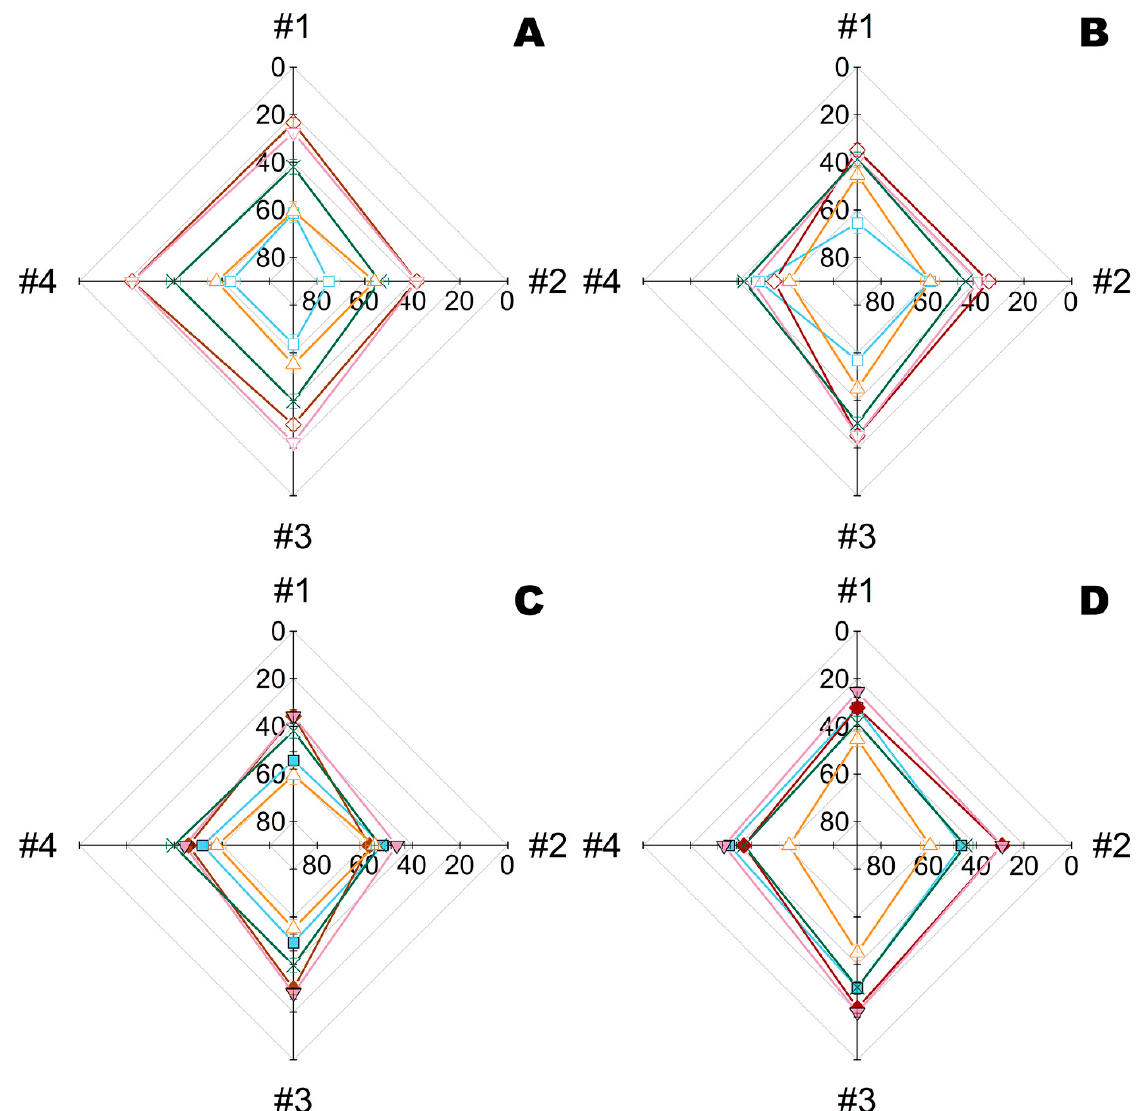
Figure 5. Residual intracellular ATP quantity (%) in B. subtilis ( A , C ) and E. coli bacterial cells ( B , D ) exposed for 24 h on multiple fiber materials (#1, #2, #3, and #4) treated with Zn ( A , B ) or Ta NPs ( C , D ), enzymes (His 6 -OPH or PGA), or their combinations. ATP of bacterial cells similarly exposed on the same materials with treatment by buffer (i.e., controls) was taken as 100%. All solutions were prepared in a Na-carbonate buffer (pH 9.5) and enzymes were additionally stabilized in complexes